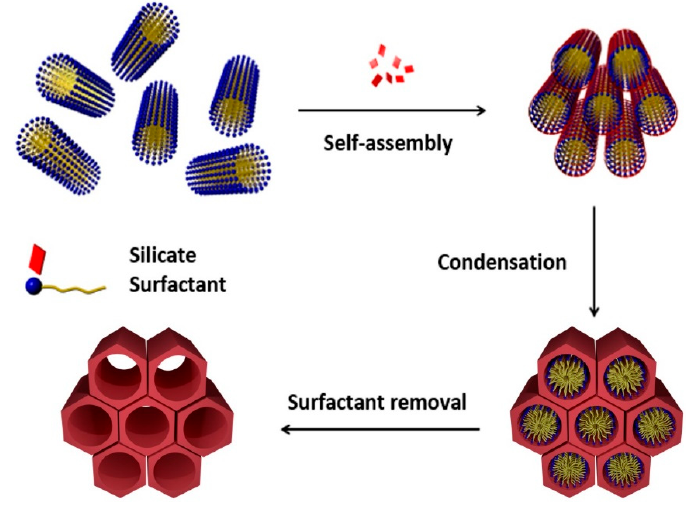
Figure 1. Preparation of